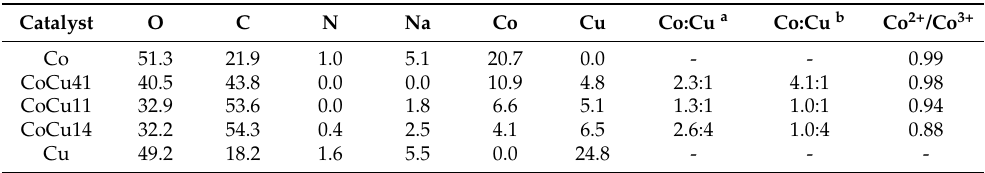
Table 5. Surface concentrations of the elements in at. % determined by XPS analysis of the examined Co-Cu oxide